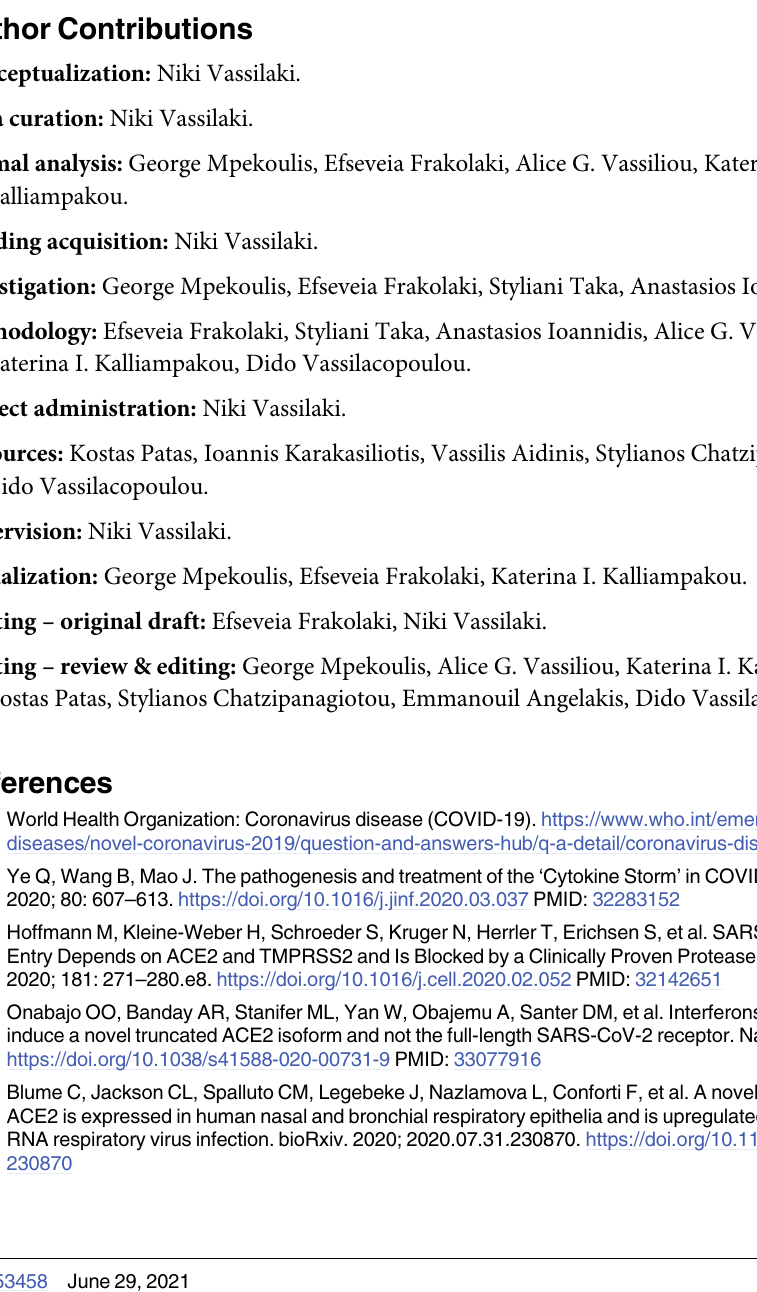
S2 Table. Demographic data of influenza positive and negative